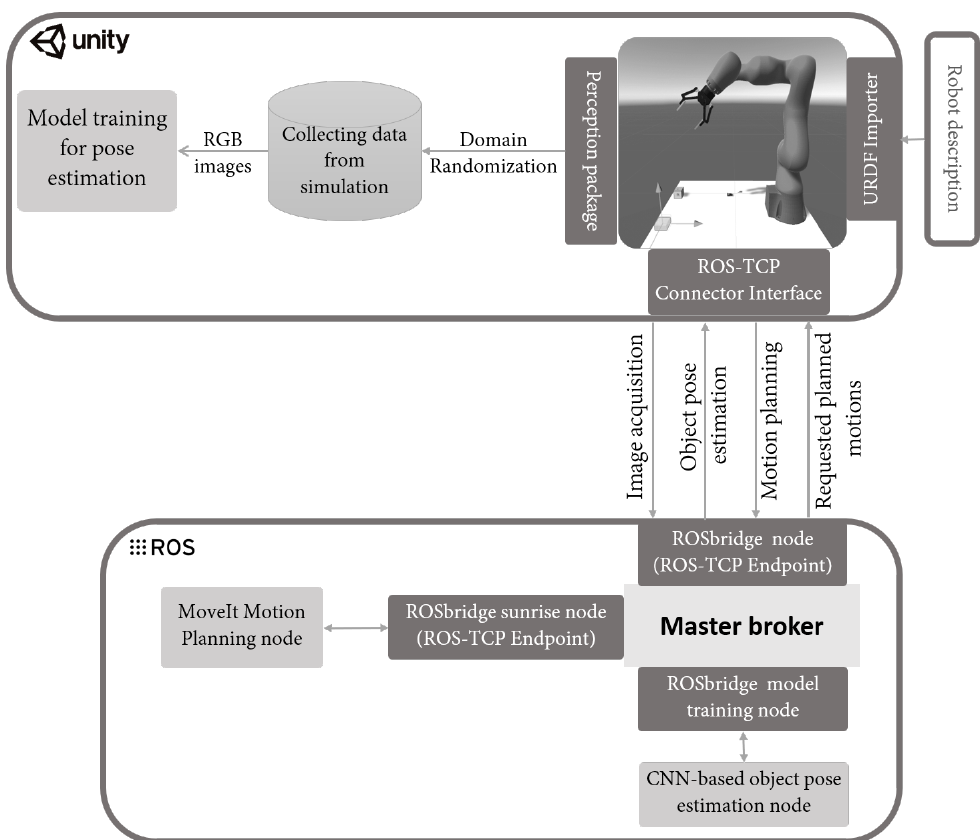
Figure 9. The RoS-based communication procedure during the autonomous decision-making process.